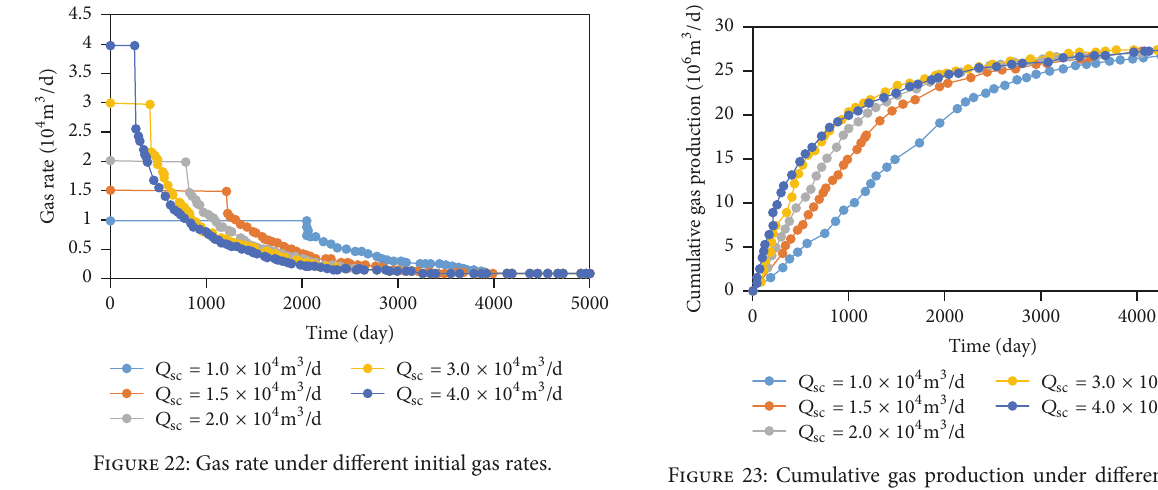
Figure 23: Cumulative gas production under different initial gas